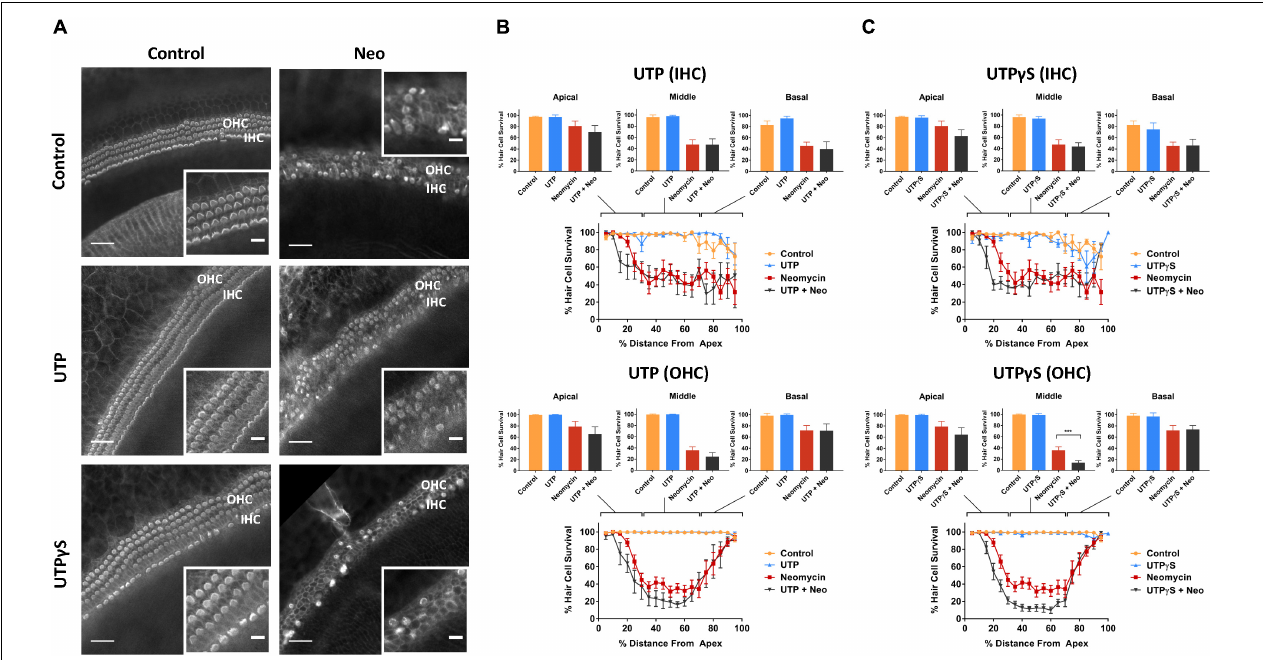
FIGURE 3 | Effect of UTP or UTP γ S supplementation on hair cell survival in the neomycin-treated mouse P3 organ of Corti explant. (A) Cochlear explants (middle segment) incubated in normal culture medium enriched with UTP or UTP γ S for 42 h with or without neomycin administration (1 mM, 3 h) in the middle of the timeframe. IHCs, inner hair cells; OHCs, outer hair cells. Scale bars: main, 30 µ m; inset, 10 µ m. (B) UTP (100 µ M) had no effect on the survival of IHC and OHC in normal culture medium or culture medium containing neomycin. Data presented as mean ± SEM (UTP, n = 6 and UTP + neomycin, n = 6). (C) UTP γ S did not affect the survival of IHC, but significantly reduced the survival of OHC ( ∗∗∗ p < 0.001, one-way ANOVA) in the middle segment of the cochlea. Data presented as mean ± SEM (UTP γ S, n = 6 and UTP γ S + neomycin, n =